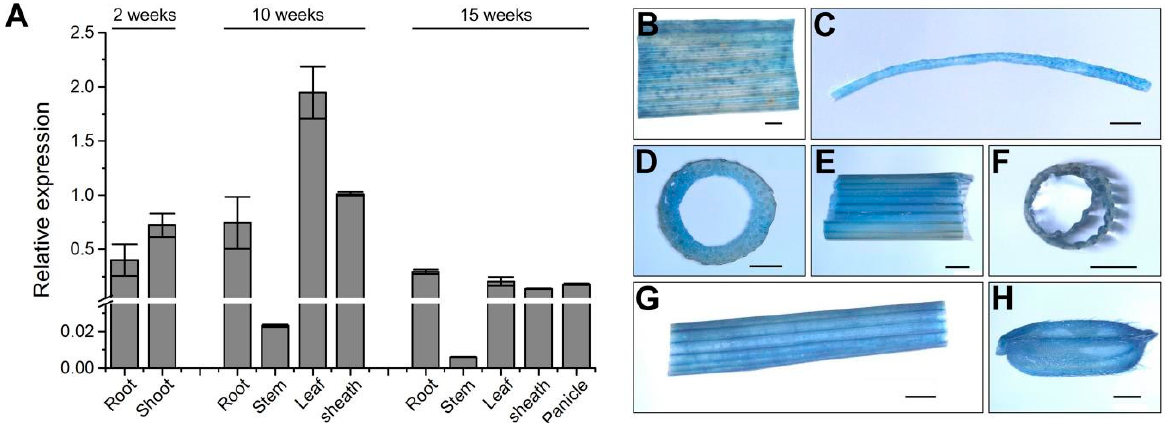
Figure 3. Relative expression of Osspl26 and GUS transient expression assay. ( A ) The relative expression level of Osspl26 in different tissues of IR64 at 2 weeks, 10 weeks and 15 weeks. Data are means ± SD ( n = 3); ( B – H ) GUS signals detected in different tissues. Leaf ( B ), root ( C ), stem cross- section ( D ), stem ( E ), leaf sheath cross-section ( F ), leaf sheath ( G ), young spikelet ( H ). Bars = 1 mm.